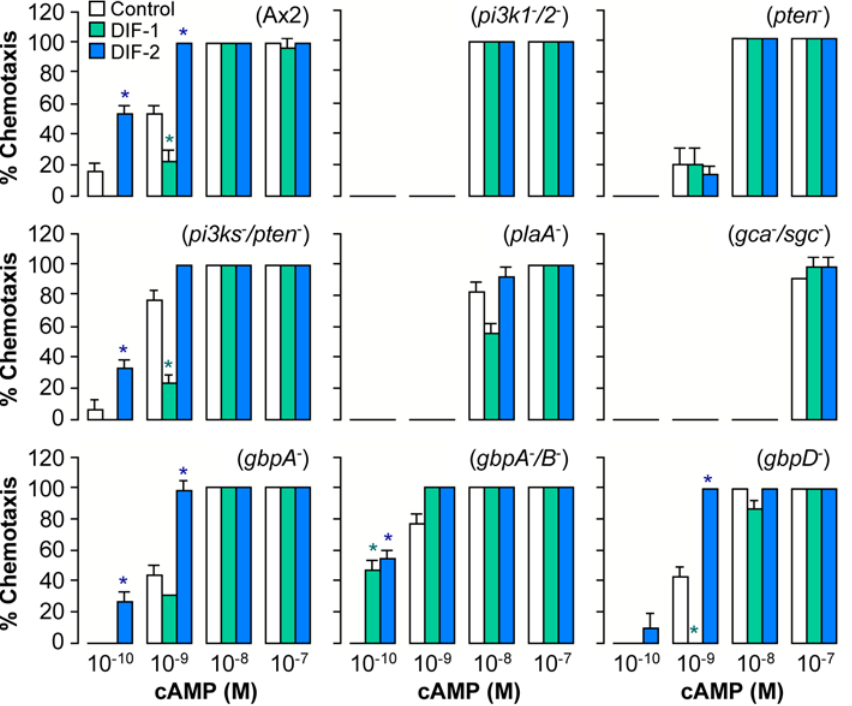
Figure 5. Effects of DIF-1 and DIF-2 on chemotaxis of various mutants. Various mutants starved for 6 h were spotted on PB agar containing 3 mM caffeine (Control) plus 100 nM DIF-1 or DIF-2 and assayed for chemotaxis toward the indicated doses of cAMP. Data are the mean and s.d. (bars) of three independent experiments (n=3). * P , 0.05, as compared with Control. pi3k1 and pi3k2 : genes of phosphoinositide-3 kinase. pten : phasphotase and tensin homolog gene. plaA : phospholipase A2 gene. gca and sgc : genes of guanylyl cyclase A and soluble guanylyl cyclase. gbpA, gbpB , and gbpD : genes of cGMP-binding protein A, B, and D, respectively. Note that chemotaxis toward low concentrations of cAMP was impaired in pi3k1 - /2 - , pten - , plaA - , and gca - /sgc - , in which the chemotaxis-modulating effects of DIFs were not observed, and that DIFs showed essentially the same effects in gbpA - /B - as seen in gbpB - cells (Fig. 6A).